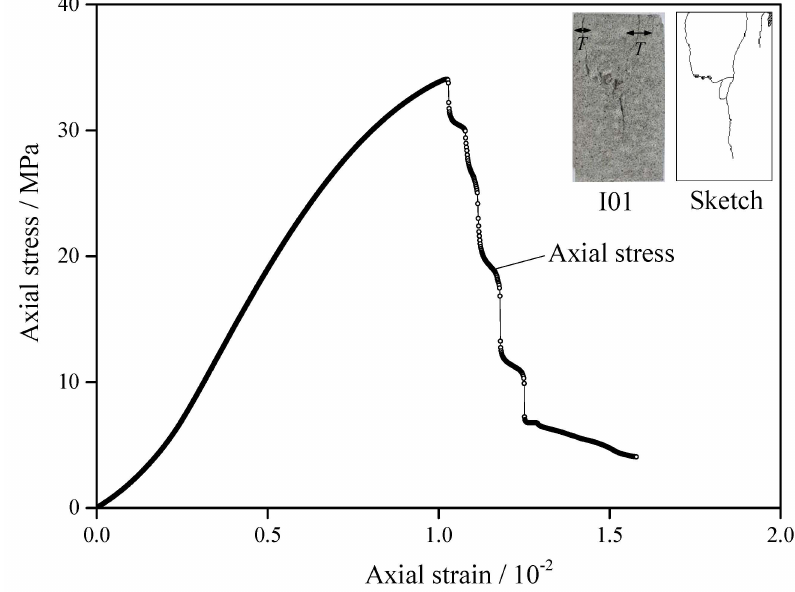
Figure 3. Axial stress–strain curve of the intact specimen under uniaxial